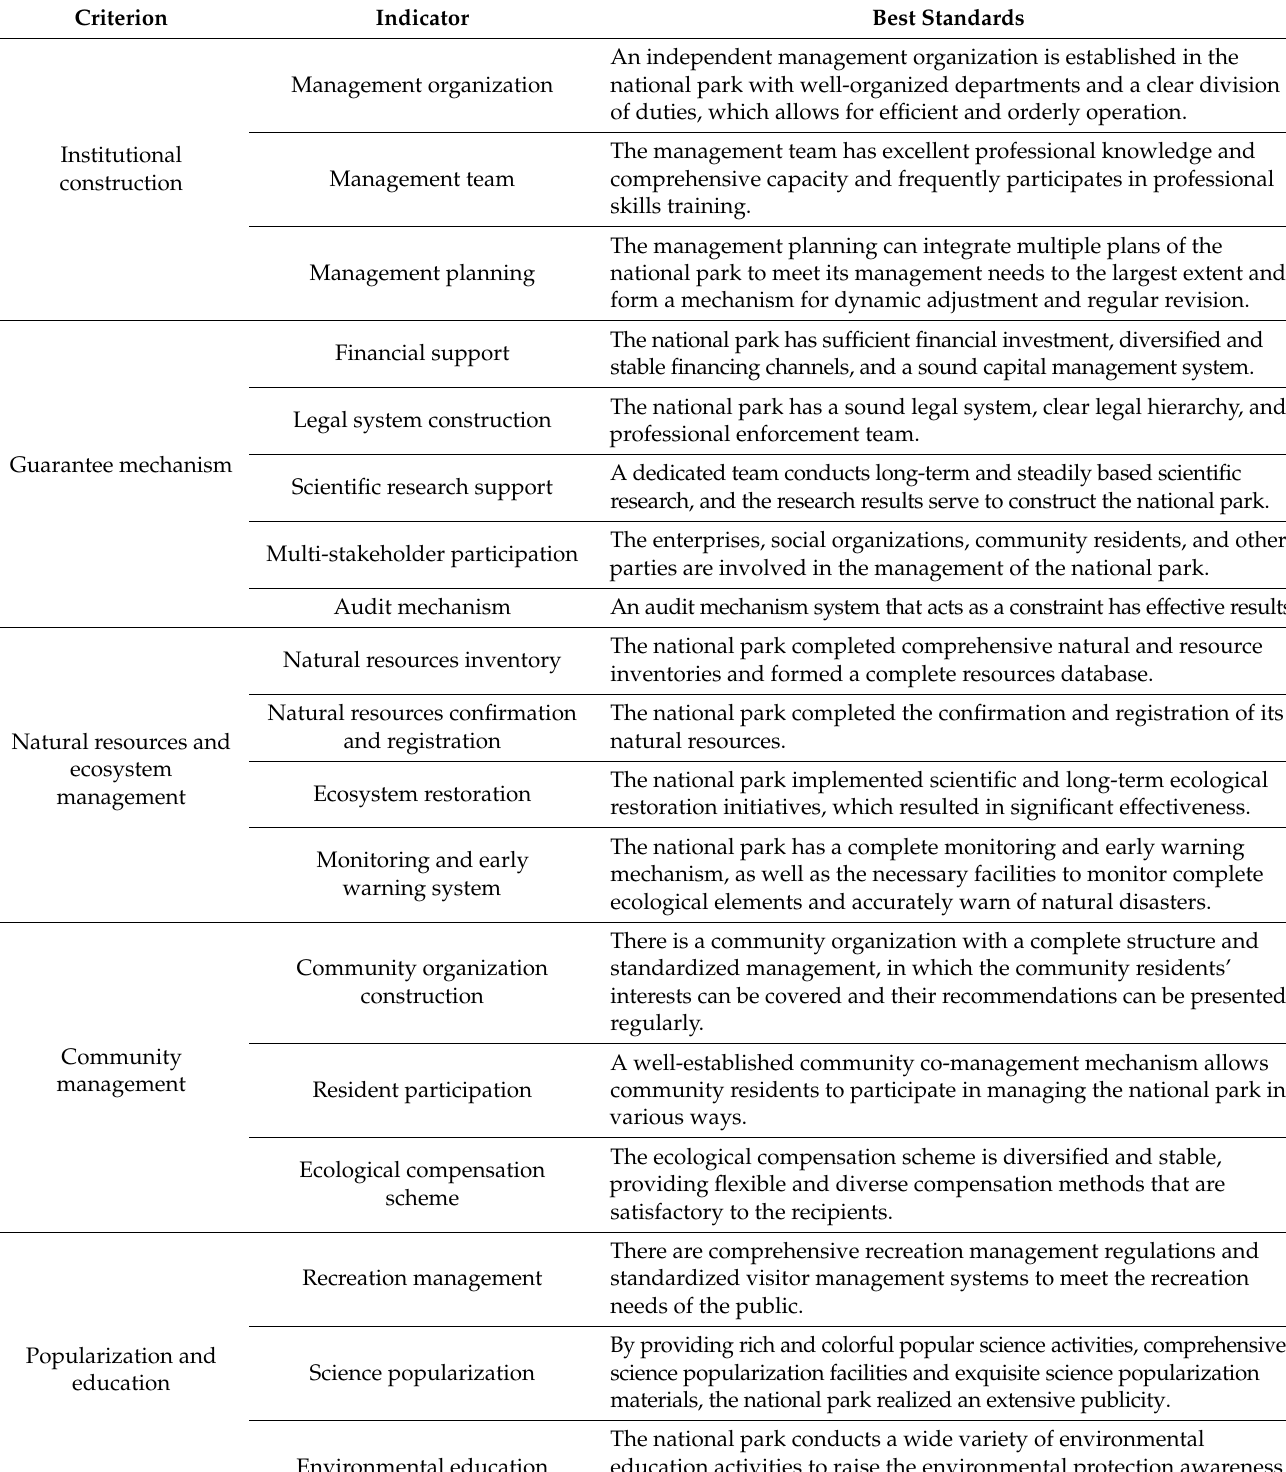
Table 1. Evaluation indicators of the best practice-based (BPB) method and their best